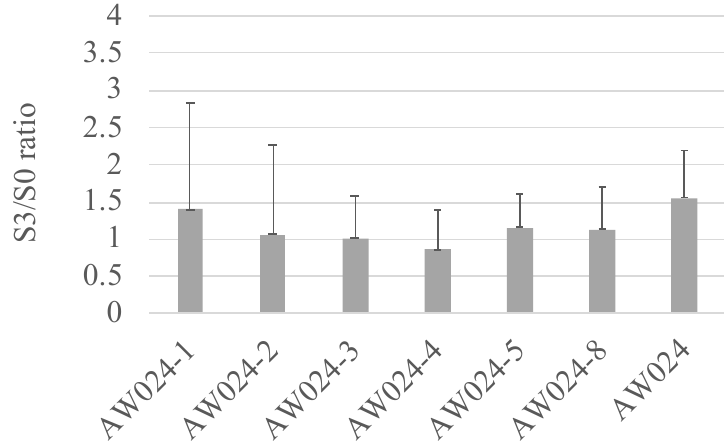
Figure 6. Growth rate of yeast mutants. ( A ) Strains were grown overnight in synthetic complete medium then inoculated into rich medium with 3% glycerol with 0 or 3 mmol L −1 selenite. The growth rate was monitored for 48 h, and maximal growth rate (doubling time) was determined as described in methods, and is shown on the graph, with the error bars representing the standard deviation of the measurements. ( B ) The S3/S0 ratio was determined by dividing the doubling time of the strain in 3 mmol L −1 selenite by the doubling time of the strain in 0 mmol L −1 selenite. Strains AW024-3 and AW024-4 were identified as having the lowest S3/S0 ratios. These strains